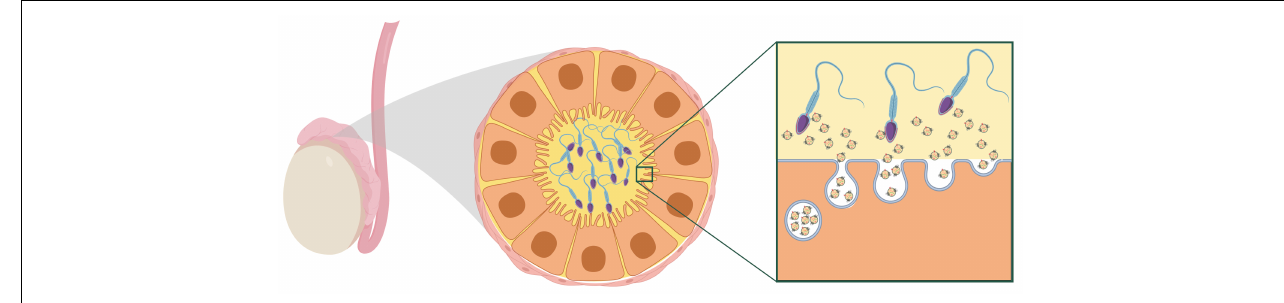
FIGURE 2 | Hypothesized model of maturing sperm interacting with extracellular vesicles within the caput epididymal lumen. Reprinted from Chan et al. (2020). Reproductive tract extracellular vesicles are sufficient to transmit intergenerational stress and program neurodevelopment. Nature Communications.